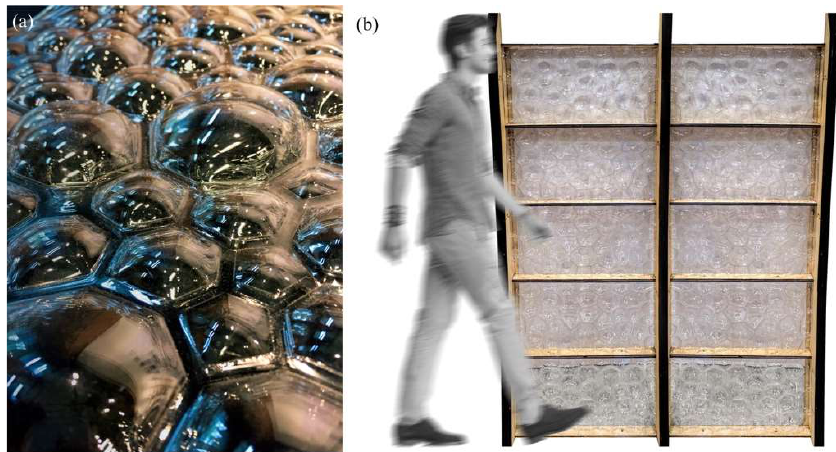
Figure 9. Ten sandwich panels were ( a ) produced by using a sequential vacuum forming process and ( b ) assembled together to form an insect-inspired facade prototype.